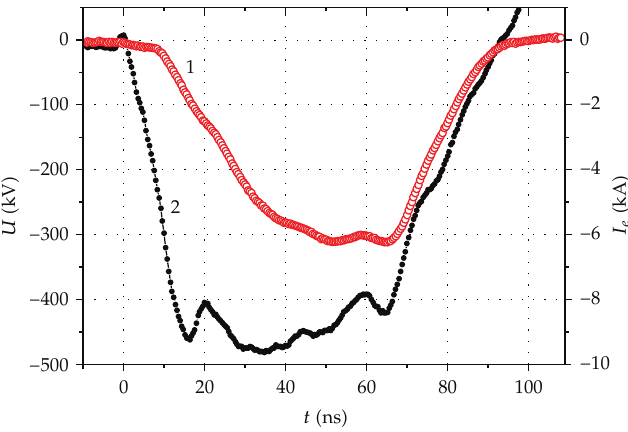
Figure 4: Waveforms of (cid:2) 1 (cid:3) electron current and (cid:2) 2 (cid:3)